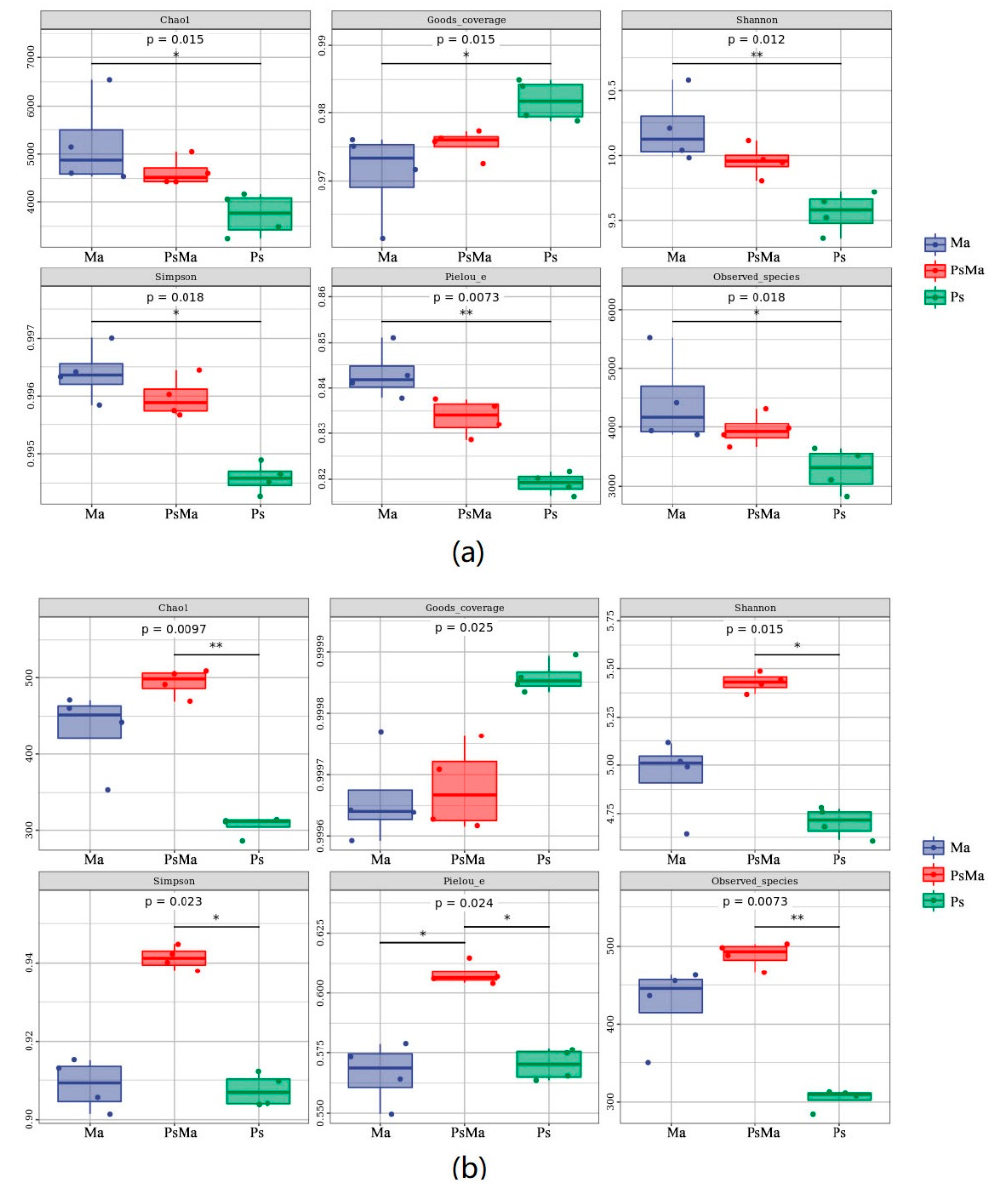
Figure 4. Litter microbial diversity index in Ma, PsMa and Ps. ( a ): Alpha diversity analysis of leaf litter bacterial community; ( b ): Alpha diversity analysis of leaf litter fungal community. Ma: Morus alba ; PsMa: Pinus sylvestris var. mongolica × Morus alba ; Ps: Pinus sylvestris var. mongolica . ** meant significant difference at 0.01 level. * meant significant difference at 0.05